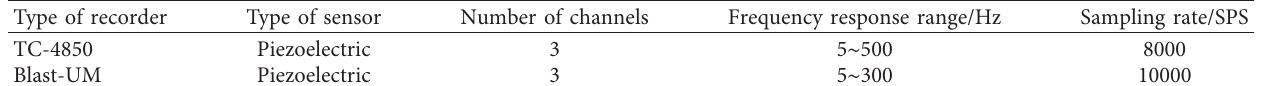
Table 2: Parameters of recorder.